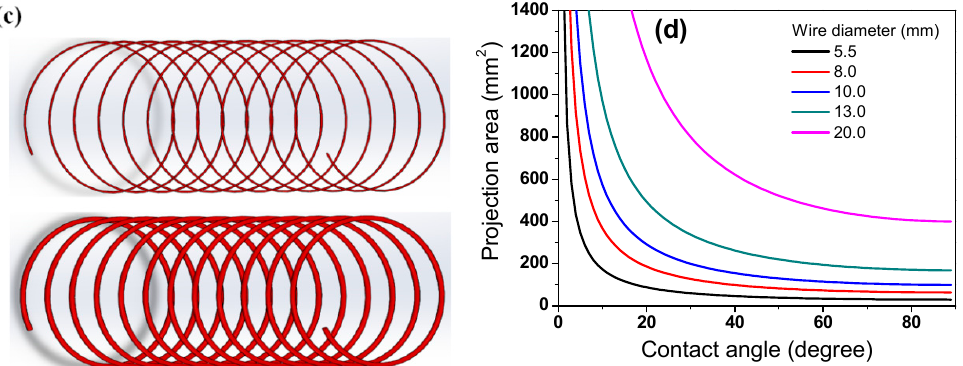
Figure 10. ( a , c ) Schematic and ( b , d ) calculated projection area of wire rod with contact angle and wire diameter.